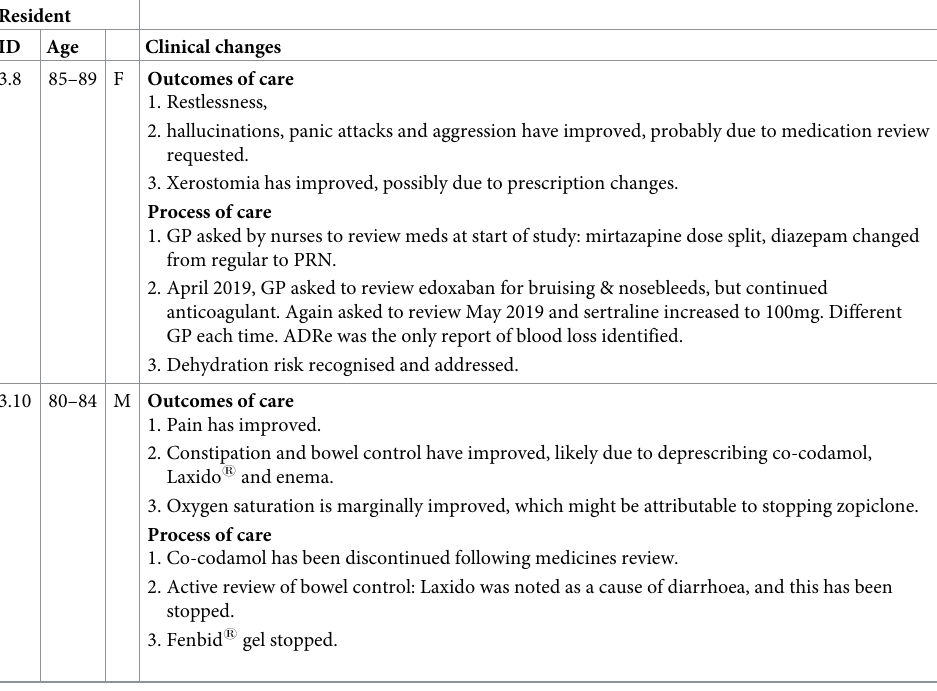
(Table 1). Examples of changes are listed in supplementary file Table